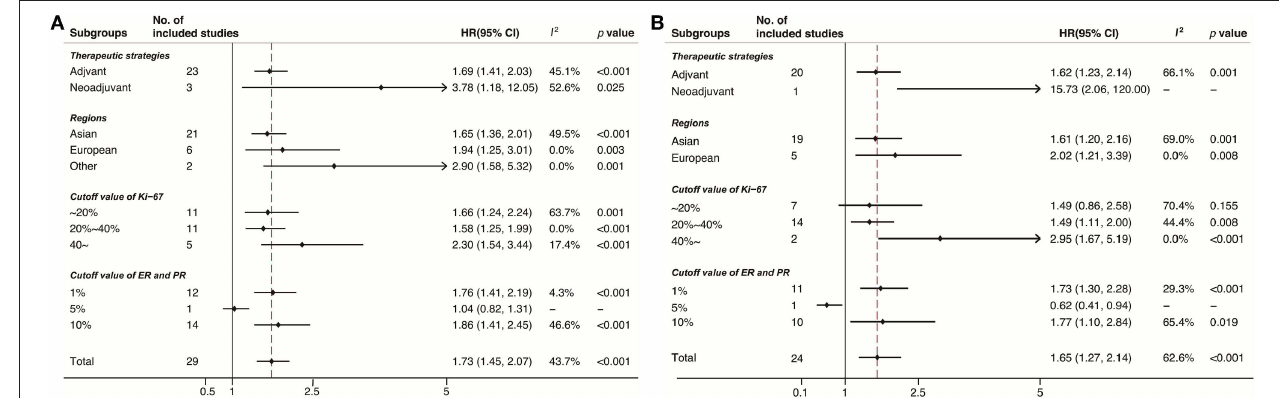
FIGURE 3 | Subgroup analysis of the association between Ki-67 and DFS (A) and OS (B) .